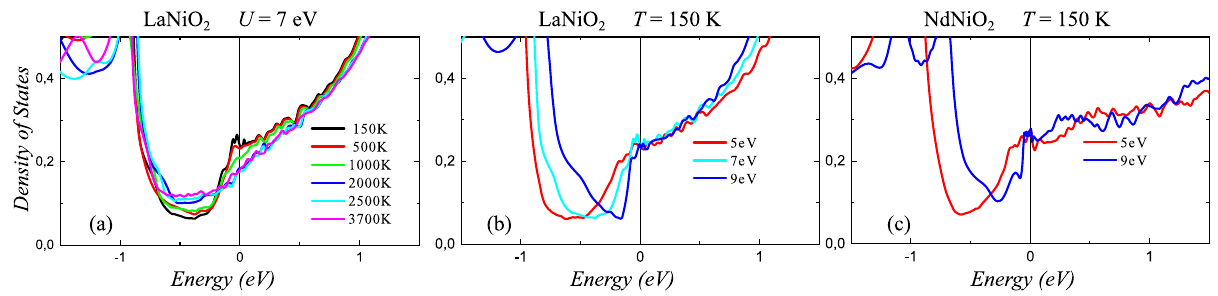
Fig. 5 Density of states (DOS) per unit cell for all non-correlated (bath) electrons. a , b show the temperature ( T ) and correlation ( U ) dependence respectively for LaNiO 2 , while c shows the correlation ( U ) dependence of DOS for NdNiO 2 .